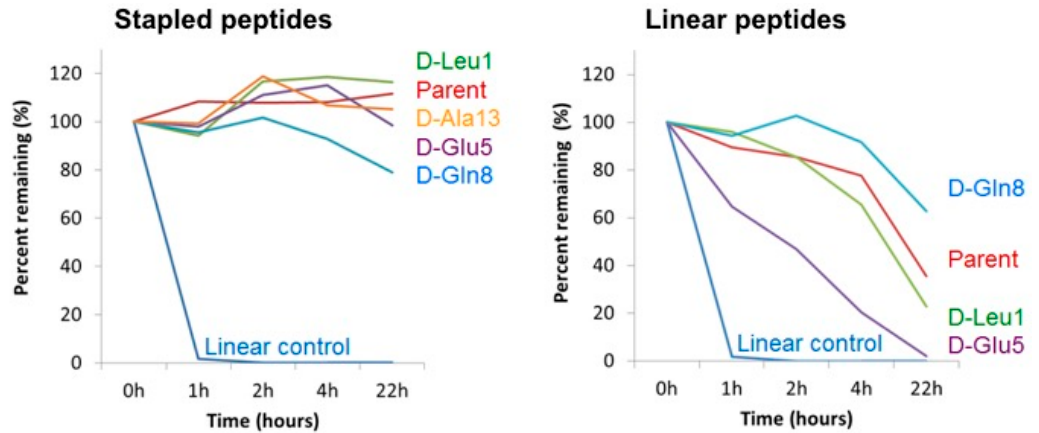
Figure 6. Stability of stapled and linear peptides in whole cell homogenate. Parent sequences correspond to MP-292 (left panel) and MP-189 (right panel). The linear control peptide is ONEG [38].